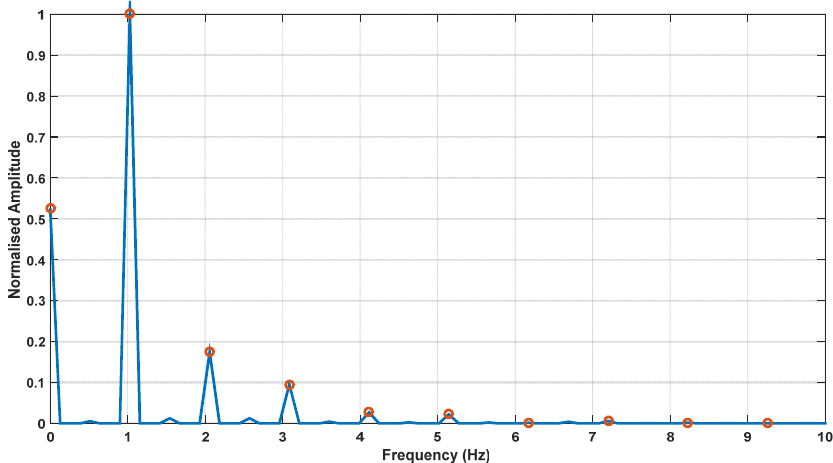
Figure 3. Frequency spectrum of a sample trial and harmonic components extracted from the function (shown by circles).